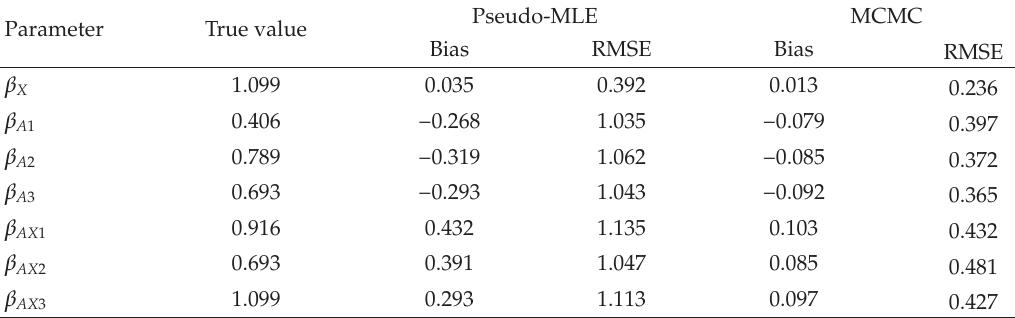
Table 2: Biases and root mean squared errors (cid:3) RMSEs (cid:4) of risk parameters obtained based on pseudo-MLE and the proposed MCMC. The results are based on 500 samples of 350 cases and 350 controls. Genotype (cid:7) 0 . 25, i (cid:7) 1 , 2. The environmental covariate (cid:3) X (cid:4) is binary is simulated at the two marker loci with P M i and measured with error misclassification probabilities being 0 . 20 for exposed and 0 . 25 for nonexposed subjects. The data is simulated and analyzed under the additive e ff ect model and the LD measure Δ M 1 M 2 (cid:7) 0 . 03.